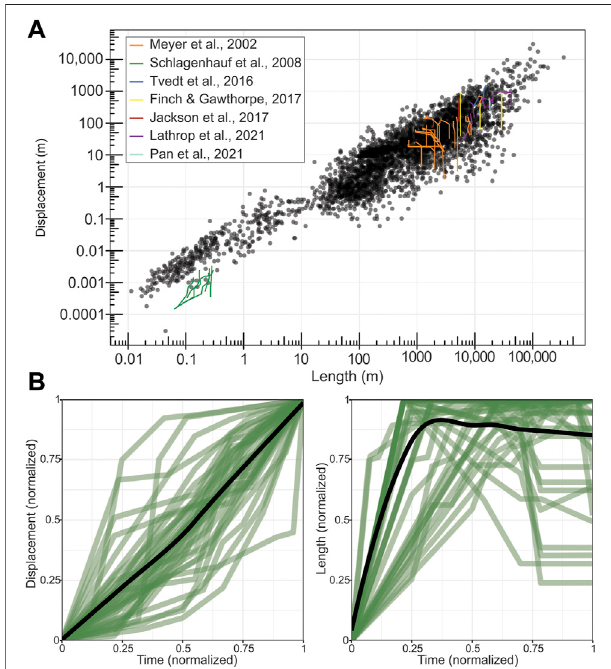
FIGURE 10 | Figures showing fault growth through time (with data extracted from Meyer et al., 2002; Schlagenhauf et al., 2008; Tvedt et al., 2016;Finch and Gawthorpe,2017; Jacksonet al., 2017;Lathropet al., 2021; Pan et al., 2021). (A) Global D/L dataset (black) for normal faults in log- log space with D/L through time data in colour above it. (B) Displacement and length through time, normalised in green, average values in black.